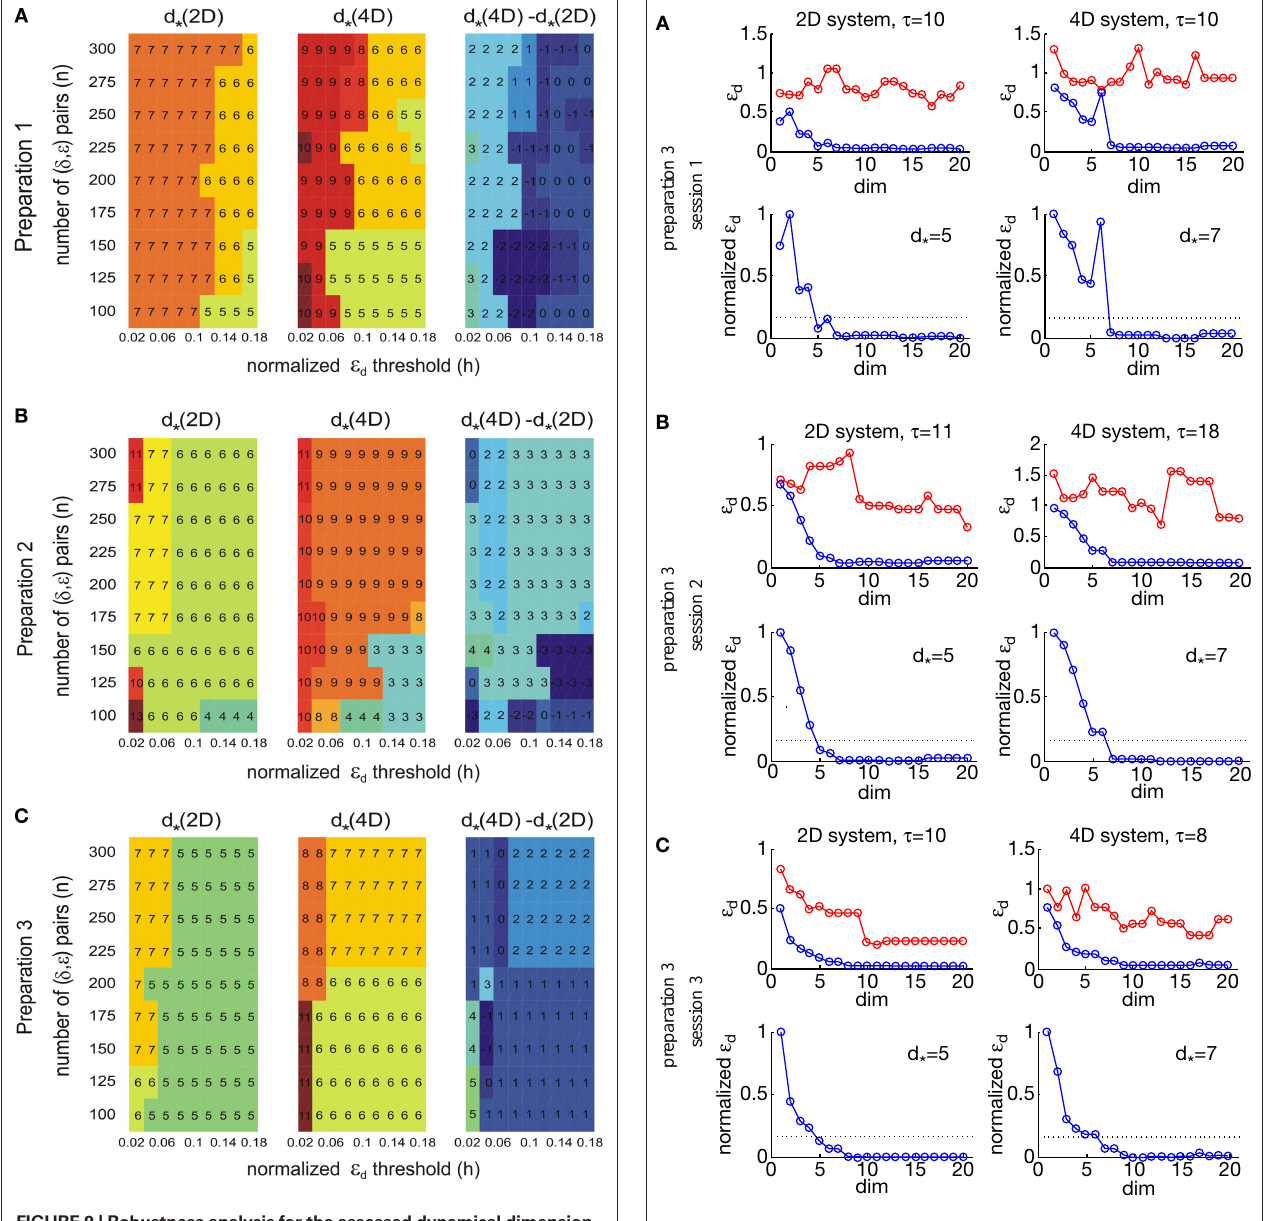
FIGURE 10 | ε and ˆ ε d as a function of d (Eqs 15 and 16) for three sessions d using preparation 3. See explanations in caption to Figure 8